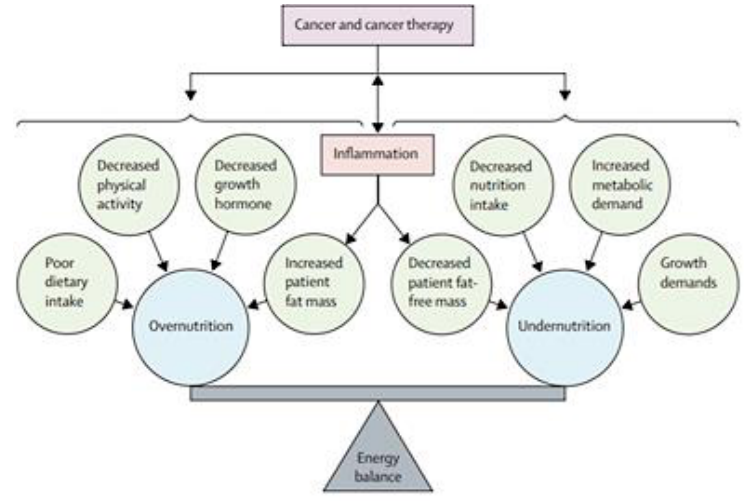
Figure 1. Energy balance in pediatric cancer